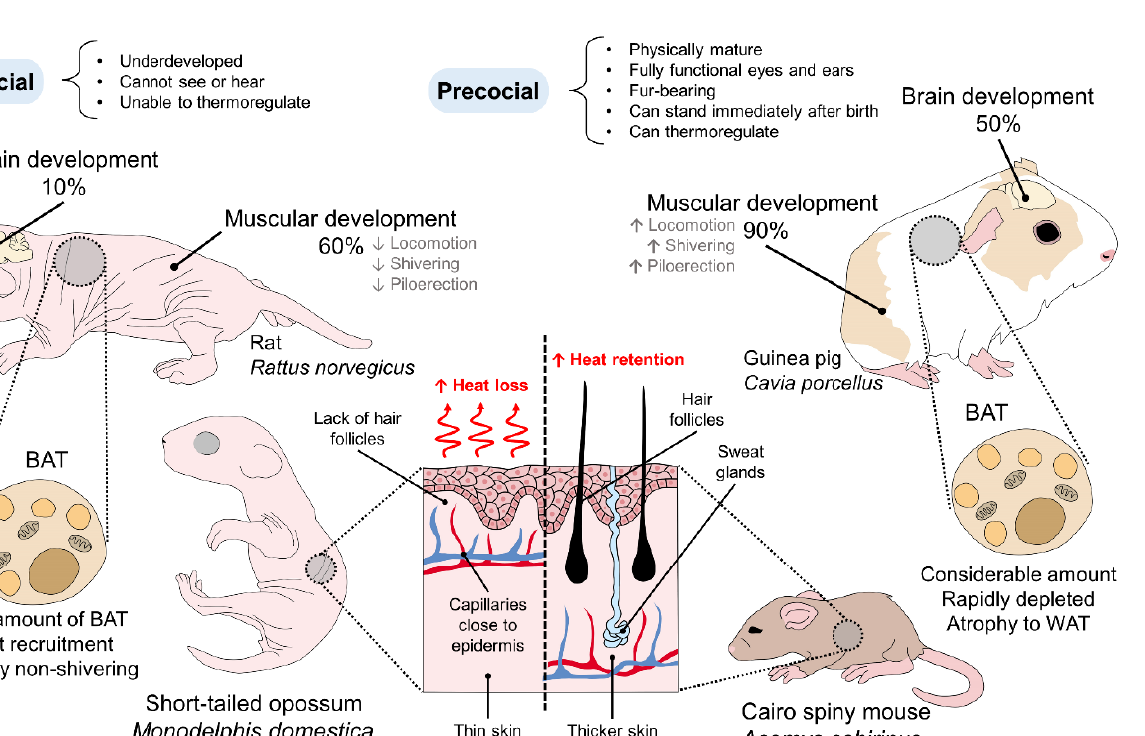
Table 1. Main mechanism of thermoregulation and its maturation time in different species. The difference between altricial and precocial species depends on the degree of neurodevelopment which can produce variations in time to achieve optimal thermoregulation between them. Precocial species reach this capacity in the first hours after birth, while altricial species develop this ability between 20 and 45 days after birth. Species